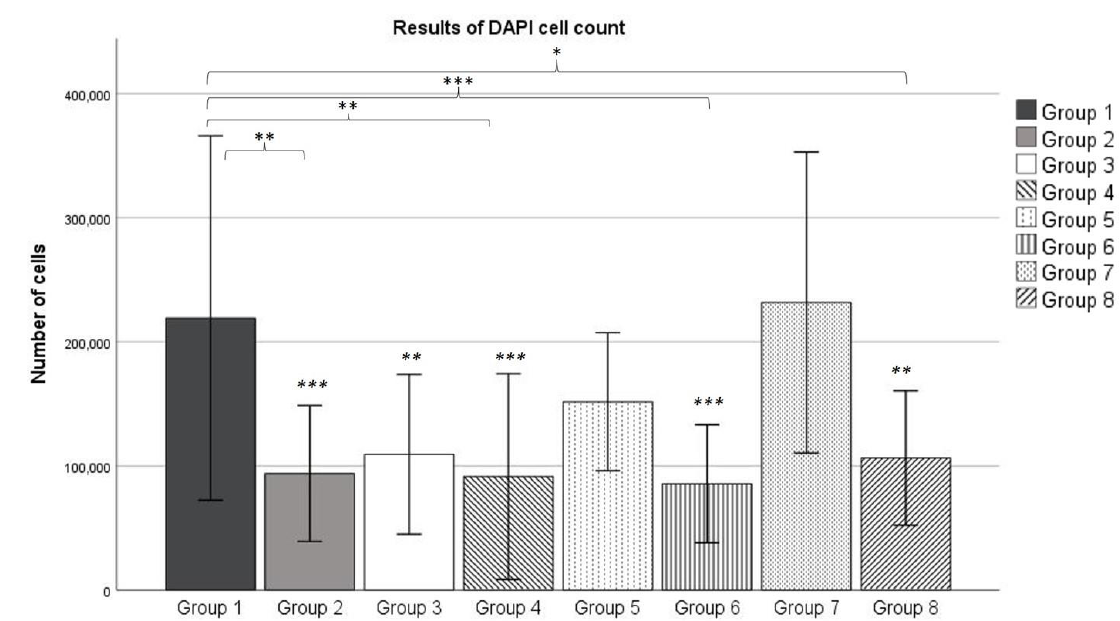
Figure 5. Mean number of cells counted after DAPI staining. The error bars show the standard deviation. Stars indicate significant differences: stars above brackets show a significant difference between the two groups linked, stars in italics show a significant difference with Group 7. * = significance 𝑝 ≤ 0.05 , ** = significance 𝑝 ≤ 0.01 *** = significance 𝑝 ≤ 0.001 . n = 3.